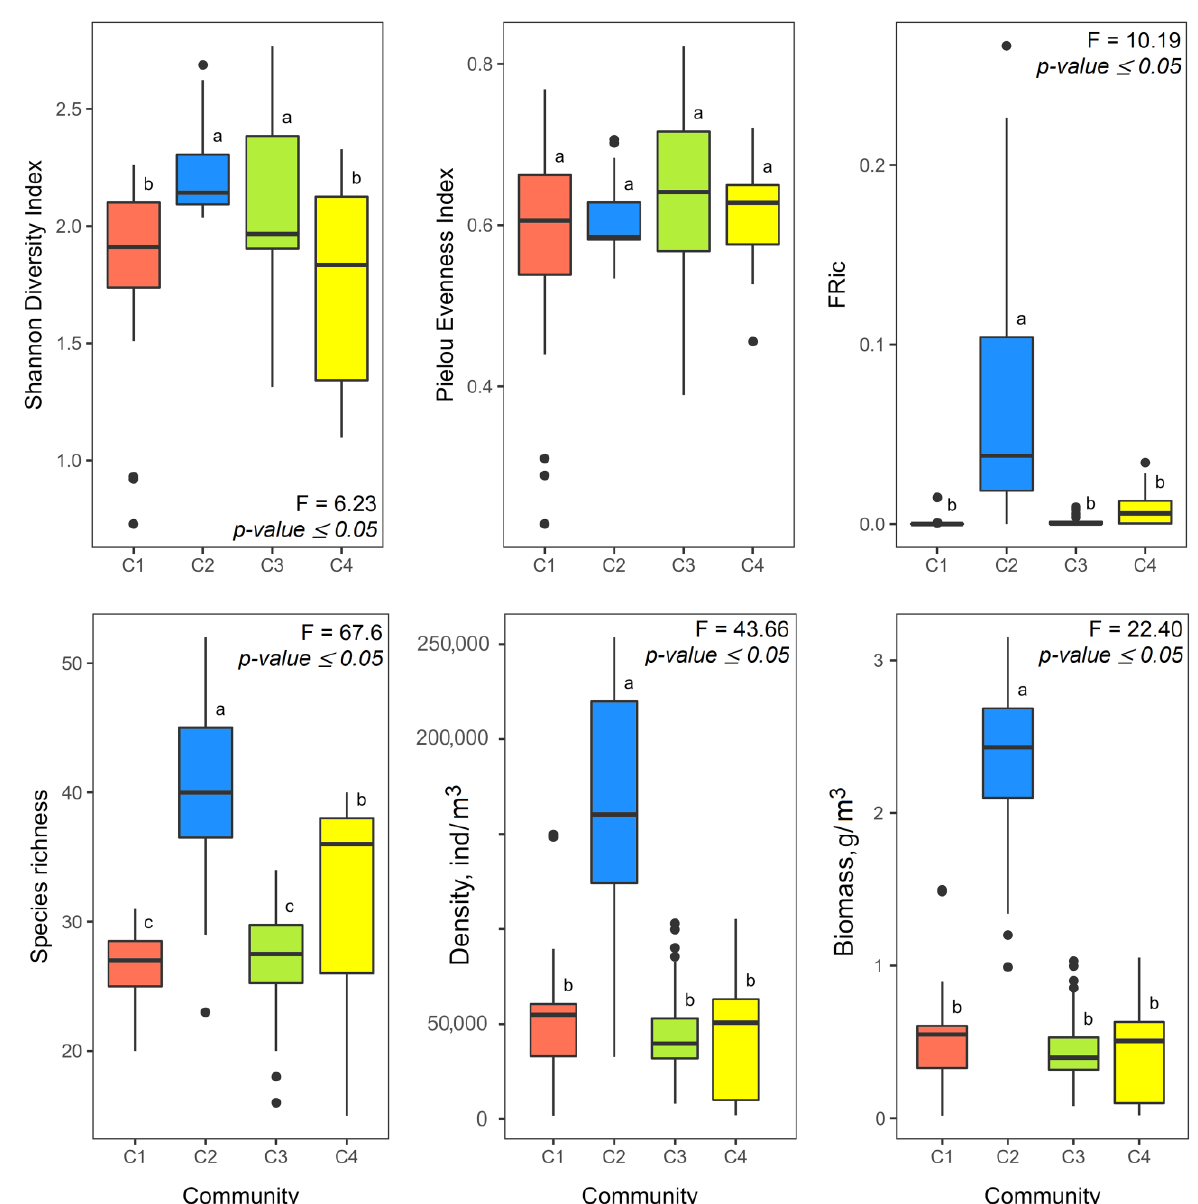
Figure 3 . Boxplots of the structural indicators of zooplankton communities in the studied mouth areas. C1, C2, C3, and C4 represent communities 1, 2, 3, and 4. Compact letter displays were added to indicate significant differences. A breakdown of the zooplankton communities and colour coding is shown in Figure 2.